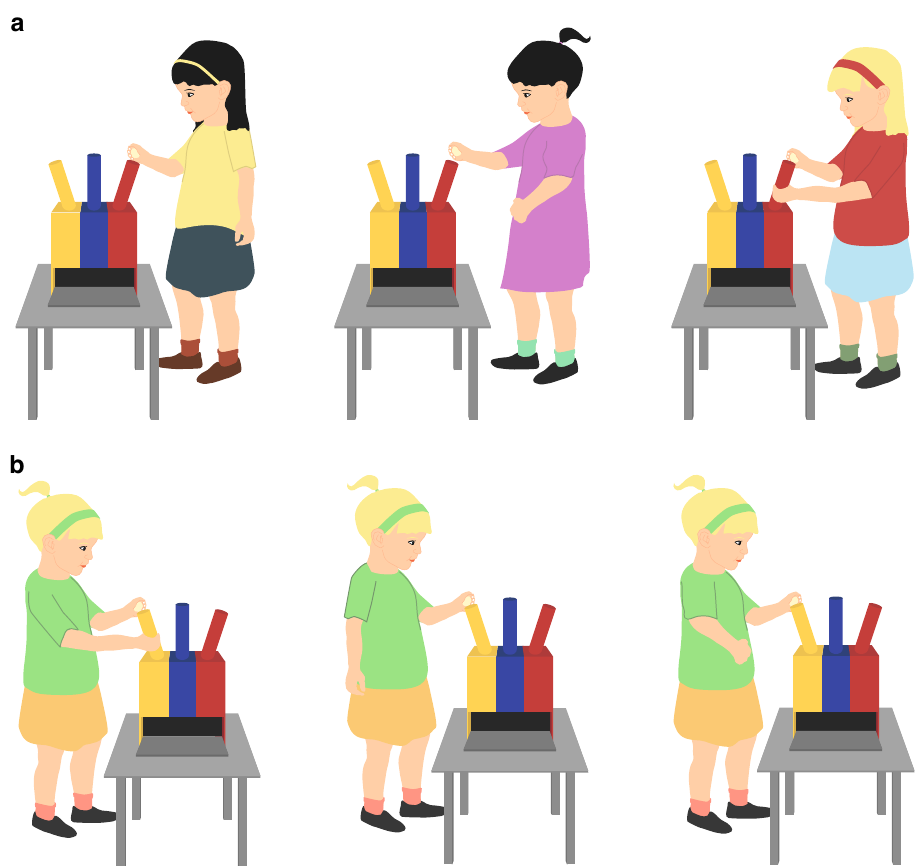
Fig. 3 Experimental set-up. Illustration of the apparatus, including the a majority and b minority demonstrations. Upon dropping the ball into the pipe, a reward was automatically released from the